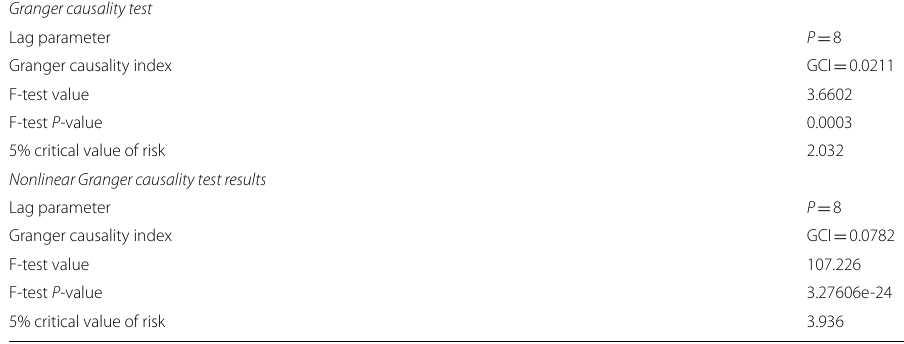
Table 3 The results of granger causality tests Granger causality test